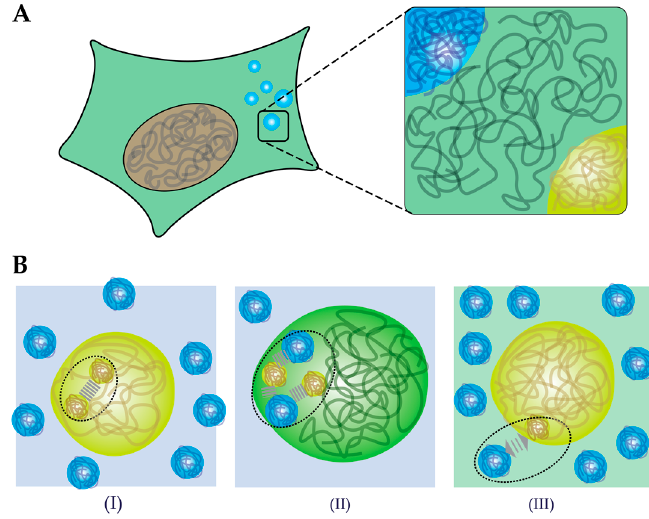
Figure 4. Cellular condensates might arise from both associative and segregative phase separation. ( A ) Phase separation results in a crowded protein-dense phase that is situated in the crowded cytosol (or nucleoplasm). ( B ) Three effects on phase separation caused by macromolecules: (I) LLPS is induced through depletion forces, increasing the attractive forces within the condensate. (II) LLPS is promoted through co-condensation of macromolecules through attractive interactions between the macromolecules and the proteins. (III) LLPS is promoted through segregation, as repulsive interactions between macromolecules and proteins lower the solubility of proteins.